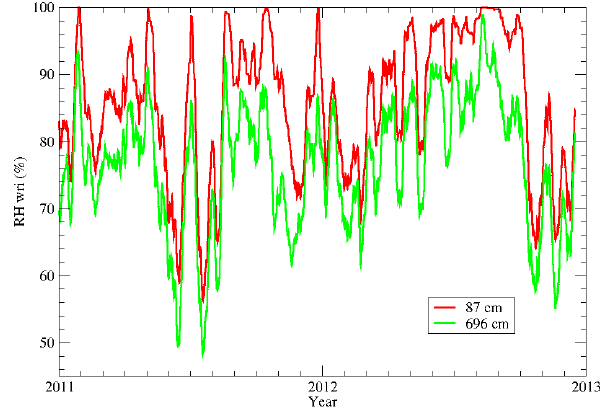
Figure 4. Relative humidity with respect to ice (RH wri ) at the lower (87cm) and upper (696cm) measurement levels. A 10-day running average is used to filter out the faster (diurnal, synoptic) components of